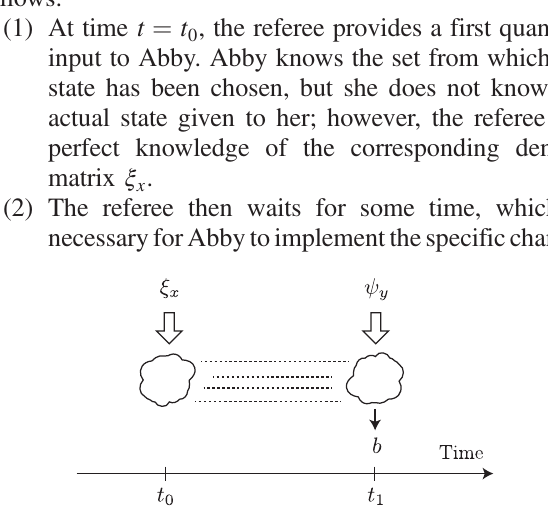
FIG. 3. The test configuration. Time flows from left to right. At time t ¼ t 0 , a first input ξ x (which must be trusted by the referee who prepares it) is handed over to the experimentalist (whose laboratory is represented by the flying cloud). After some time, at t ¼ t 1 > t 0 , the referee hands over a second input ψ y . At this point, the experimentalist is required to output a classical outcome, labeled by b . By repeating this procedure many times and observing the input/output correlation p ð b j x; y Þ so obtained, it is possible to verify whether the experimentalist is actually able or not to preserve quantum information through a time δ ¼ t − t > 0 1 0